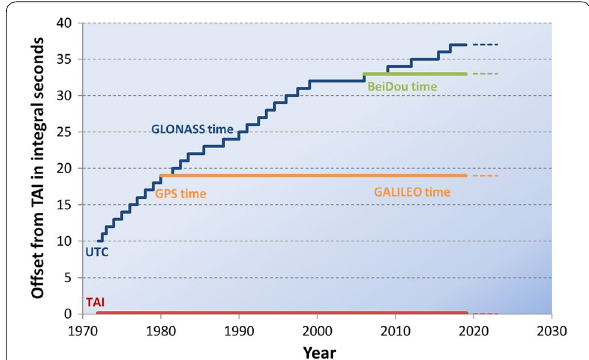
Fig. 13 Offset of GNSS system time scales and UTC versus TAI due to the introduction of leap